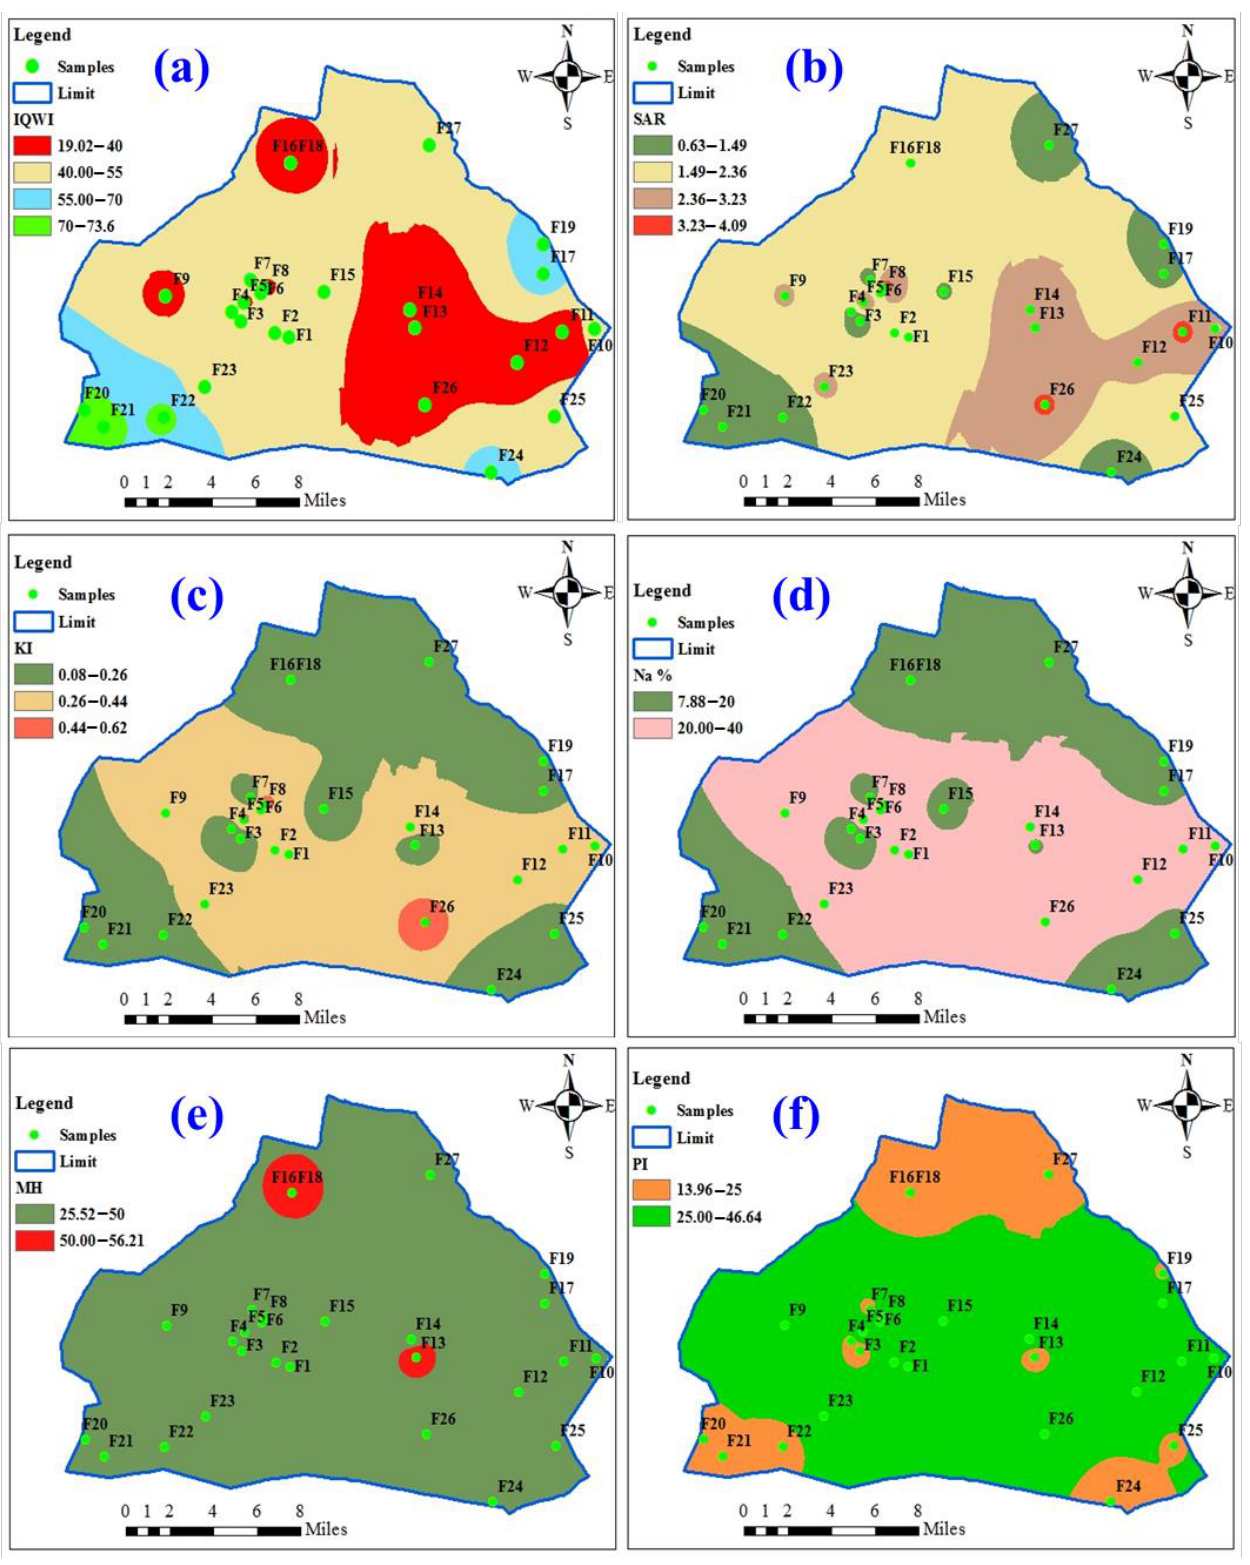
Figure 8. The spatial variation map of the Doucen plain: Irrigation water quality indices (IWQIs).